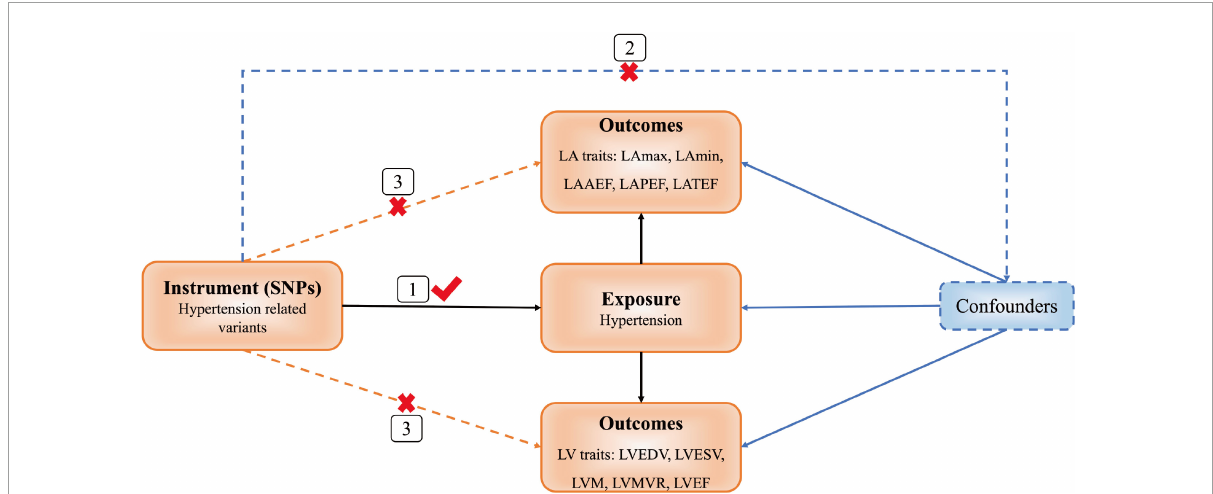
FIGURE1 Diagram of Mendelian randomization (MR) framework. SNP, single nucleotide polymorphisms; LA, left atrial; LAmax, LA maximum volumes; LAmin, LA minimum volumes; LAAEF, LA active emptying fraction; LAPEF, LA passive emptying fraction; LATEF, LA total emptying fraction; LV, left ventricular; LVEDV, LV end-diastolic volume; LVESV, LV end-systolic volume; LVM, LV mass; LVMVR, LV mass to end-diastolic volume ratio; LVEF, LV ejection